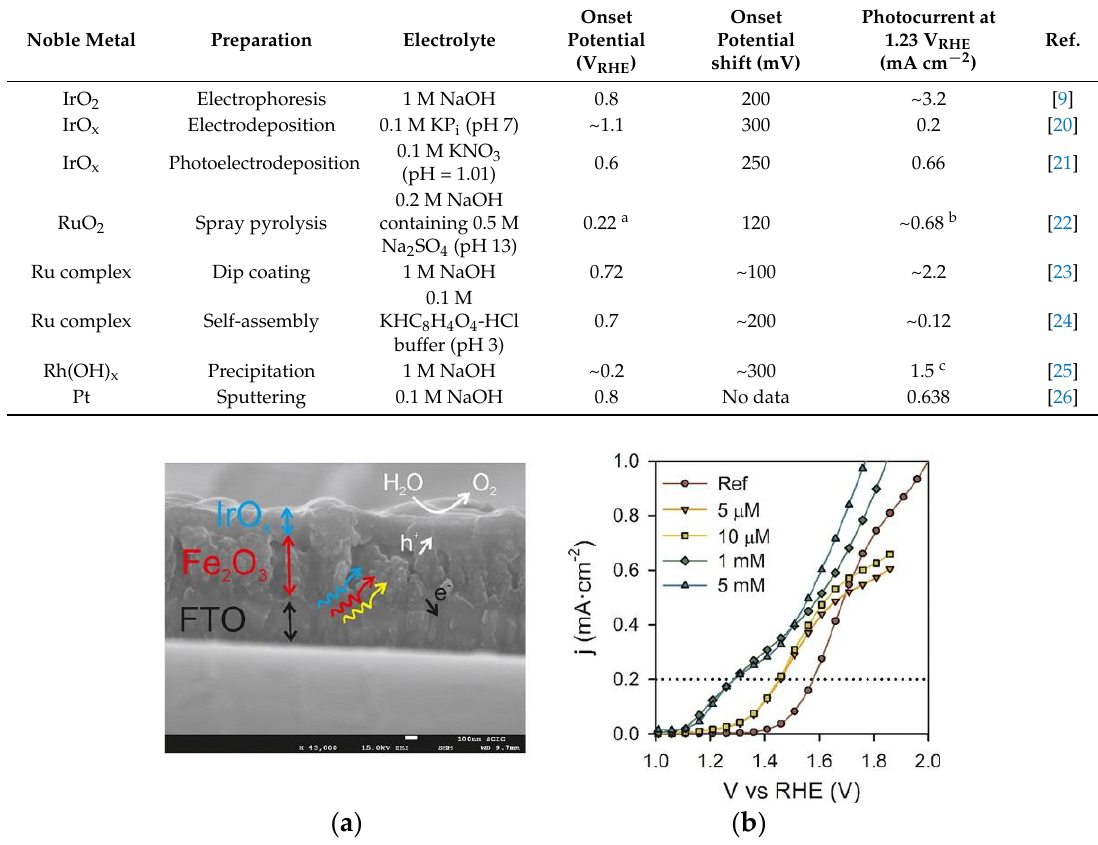
Table 1. List of noble metal co-catalysts used for surface modification on hematite nanostructures.